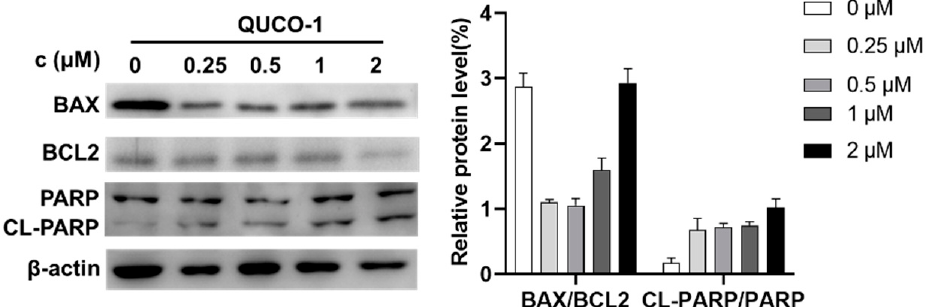
Figure 6. Western blotting analysis of apoptosis-related protein upon 48 h treatment of QUCO-1 in RKO cells.